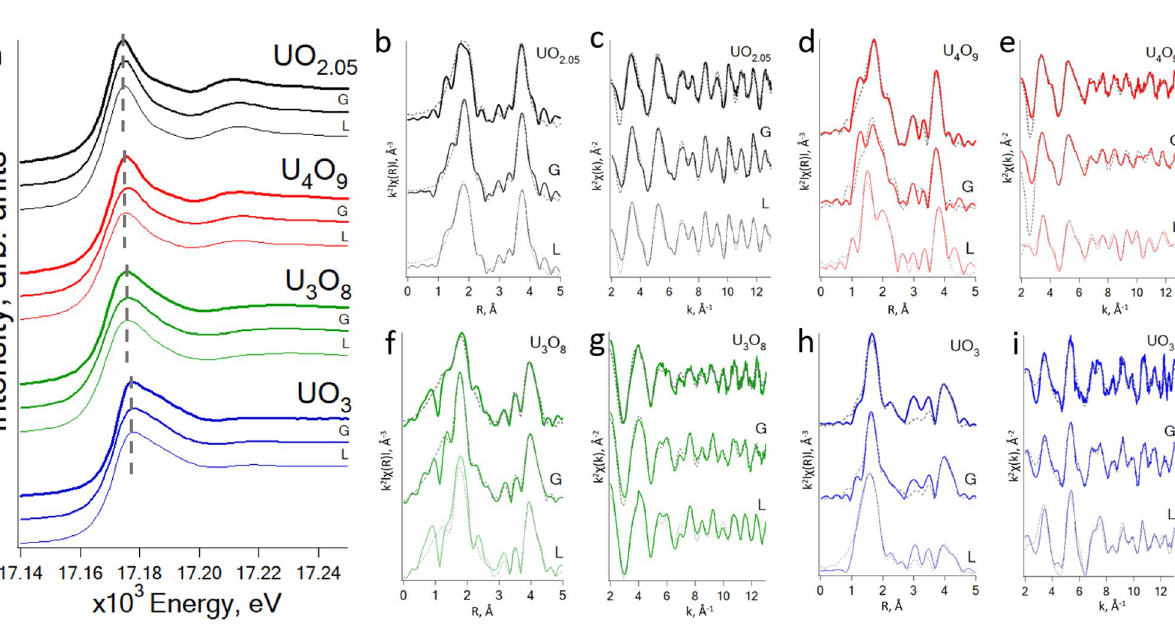
Figure 4. Comparison of U L-3 edge XAS data for initial and exposed to lung (L), gastric and intestinal (G) simulated fluids uranium oxides: ( a )—XANES; ( b , d , f , h )—EXAFS spectra; ( c , e , g , i )—corresponding Fourier transforms of the EXAFS